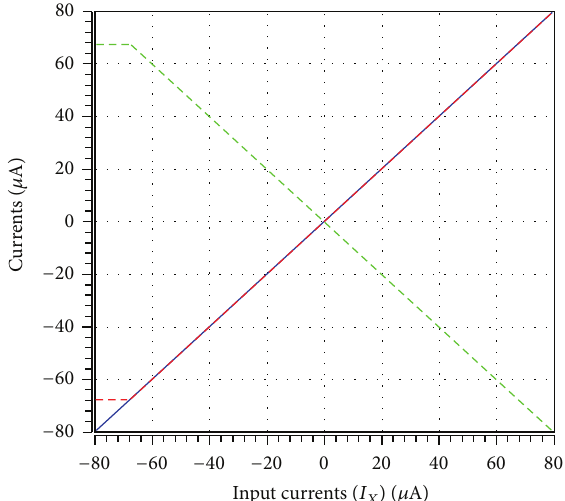
Figure 6: The DC characteristic between the 𝑋 (blue line), 𝑍 + (red line), and 𝑍− (green line) terminals currents of the ICCII.